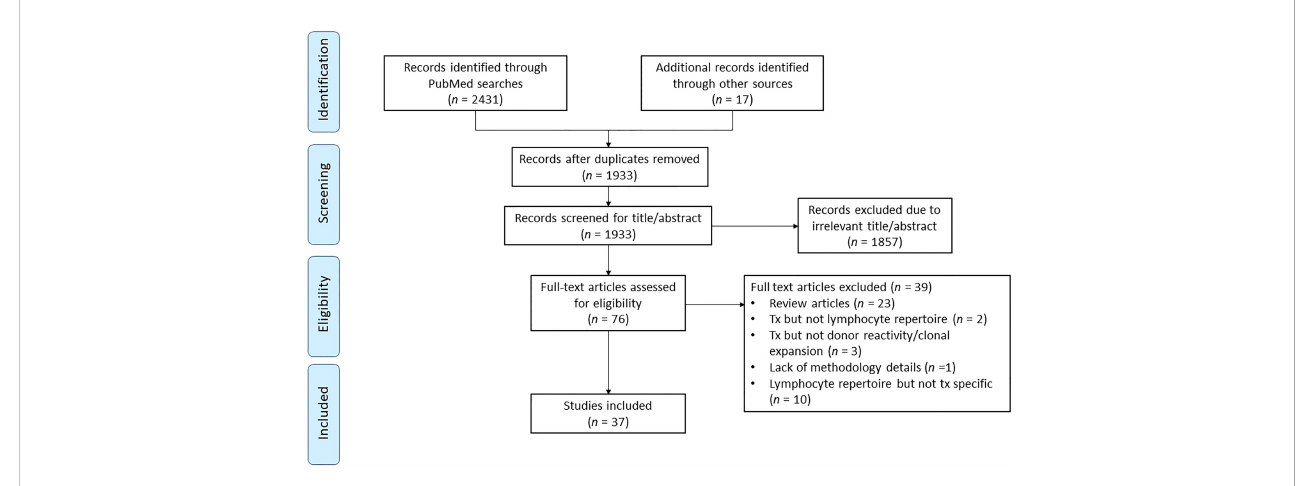
FIGURE 3 Flow diagram for records identi fi ed, included, excluded, and reasons for